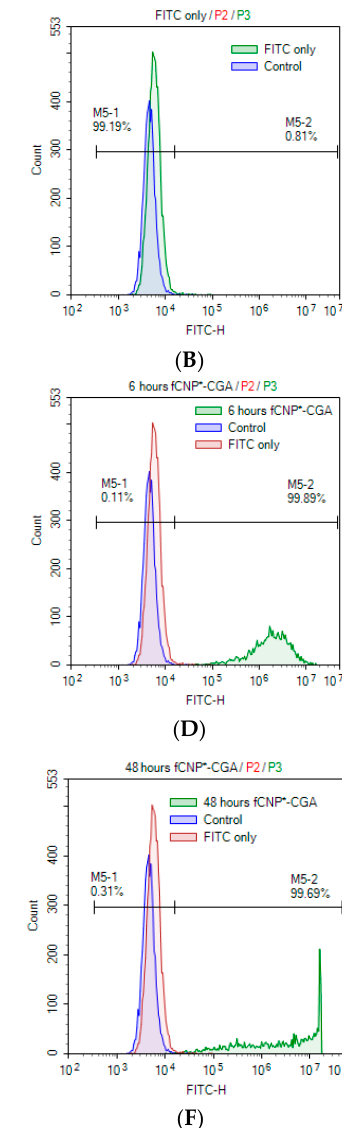
(Figure 11E), and 48 h (99.69%) (Figure 11F); signifying persistency in uptake of f CNP